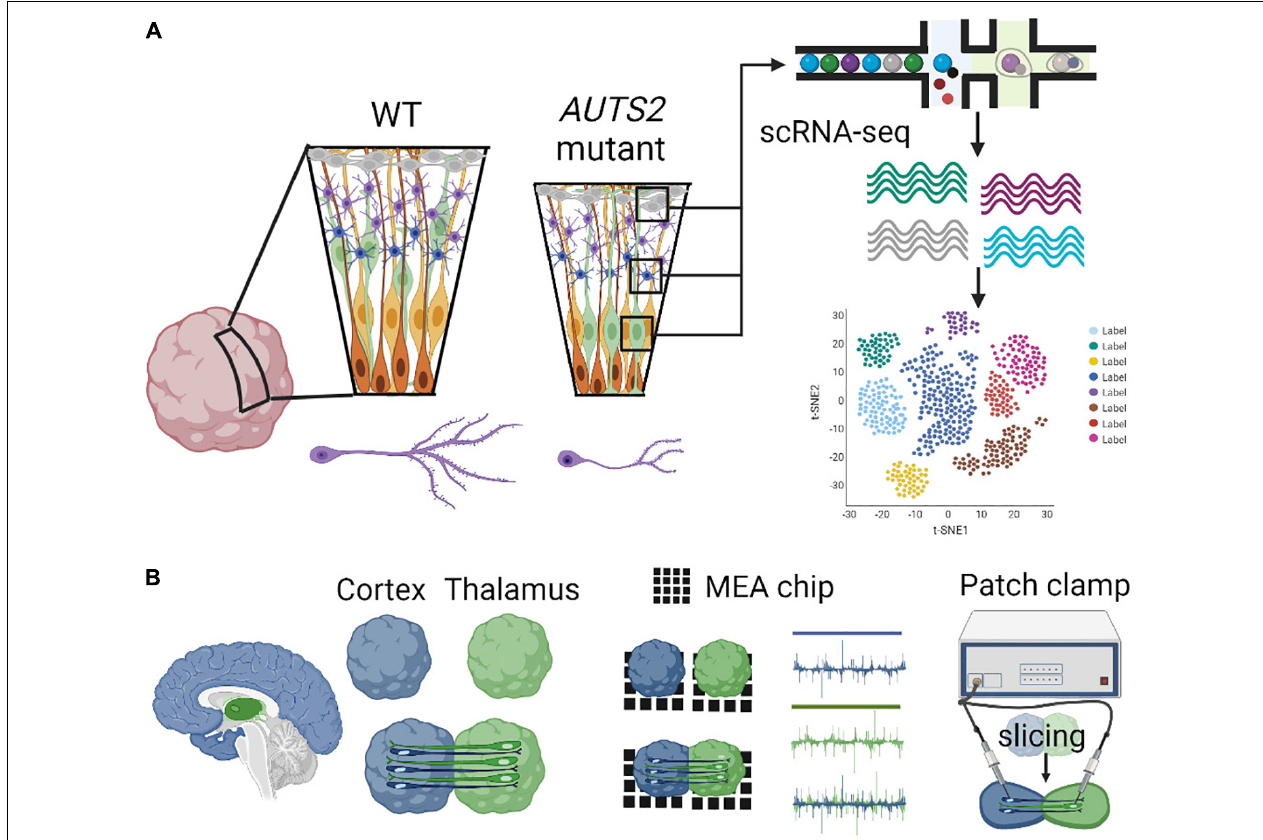
FIGURE 4 | Modeling AUTS2 syndrome using cerebral organoids. (A) AUTS2 mutant cerebral organoids have proliferative deficits in neural progenitor cells and impaired neuritogenesis in cortical neurons (left). Utilization of scRNA-seq to determine cell type specific changes in gene expression within diverse progenitor, neuronal, and glial cell populations (right). (B) Generation of assembloids through the fusion of brain region specific organoids (cortical-thalamic assembloid shown, left) investigating neural circuitry using MEA and patch-clamp electrophysiology